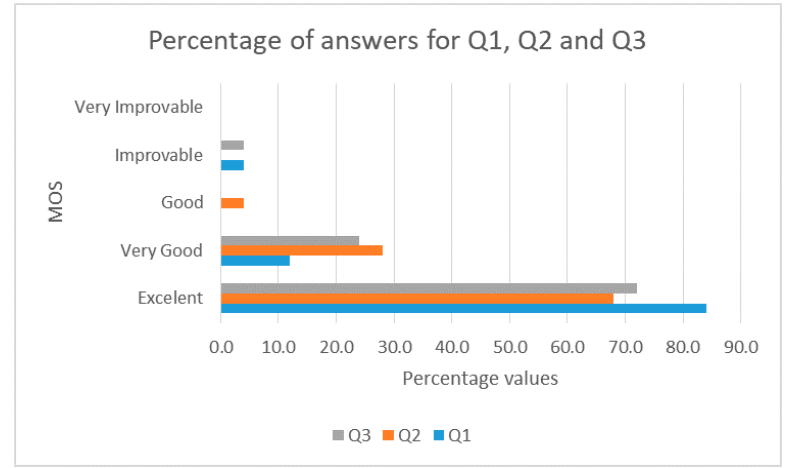
Figure 11. Percentages by categories of the MOS for Q1, Q2 and Q3.